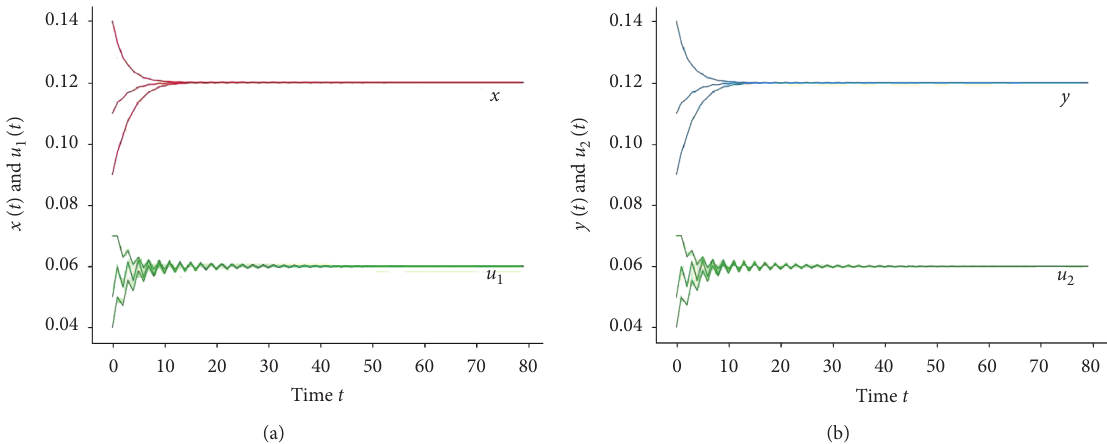
Figure 2: Dynamic behaviors of system (29) with the initial conditions (0.11, 0.11, 0.05, 0.05), (0.14, 0.14, 0.07, 0.07), and (0.09.0.09, 0.04, 0.04) when r � 2 . 1 ,a � 2 .b � 1 , e � 1 , η � 2 , and D � 1 . 8.